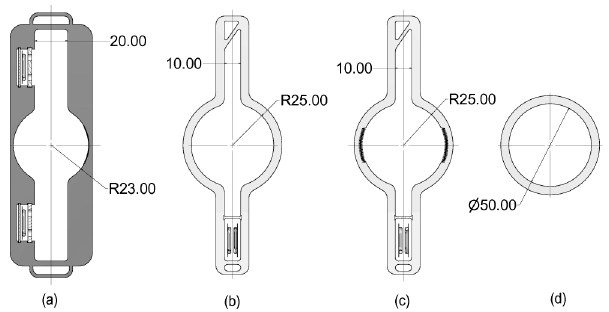
FIG. 4. Vacuum chamber profiles for the (a) wiggler magnets, (b) arc sections, (c) dipole magnets, and (d) fieldfree regions of the damping ring. Note the positions of the NEG strips, the grooves in the dipole vacuum chambers and the angled rear walls of the antechambers.